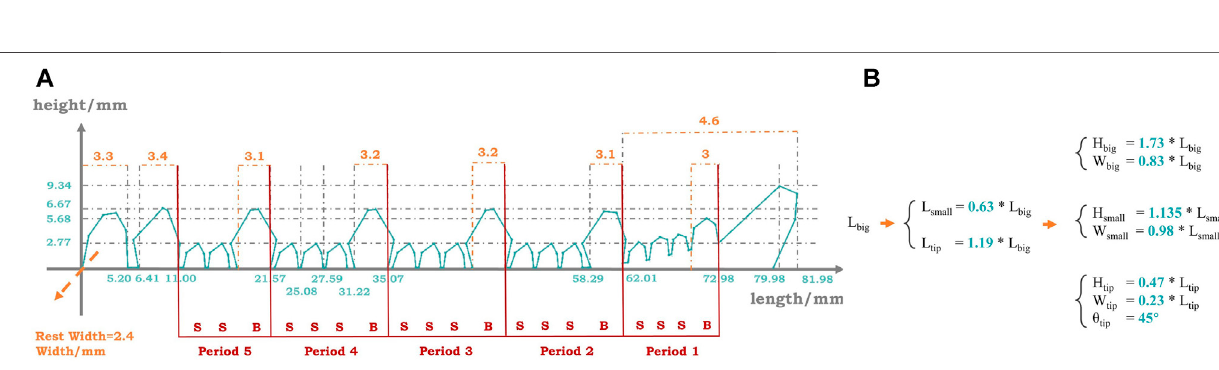
Frontiers in Robotics and AI |